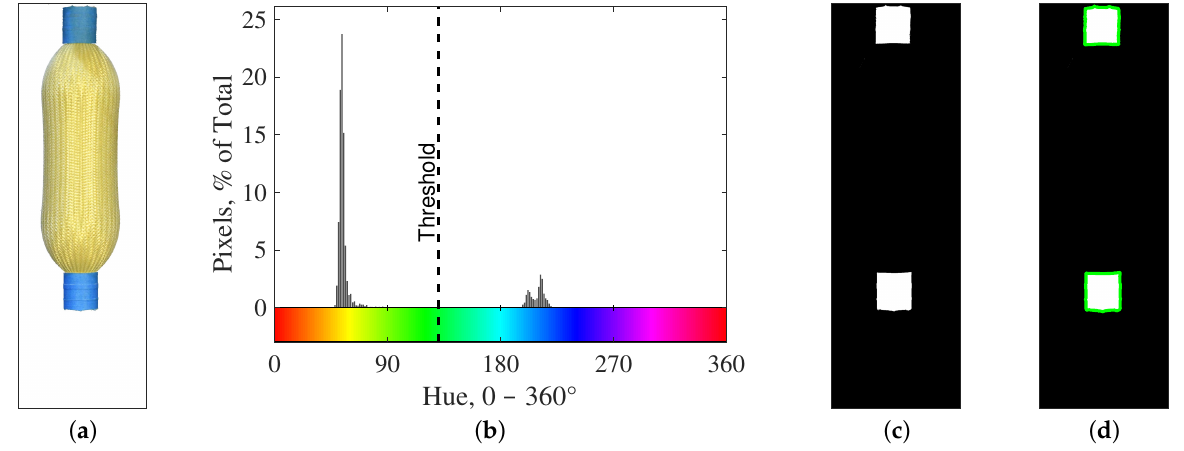
Figure 10. Identification of the end-fittings in the image: ( a ) Image of PAM only. ( b ) Step 3a: Pixel segmentation histogram using Otsu’s method to set threshold on Hue ( H ). ( c ) Step 3b: H segmented binary image. ( d ) Step 4: End-fittings outline